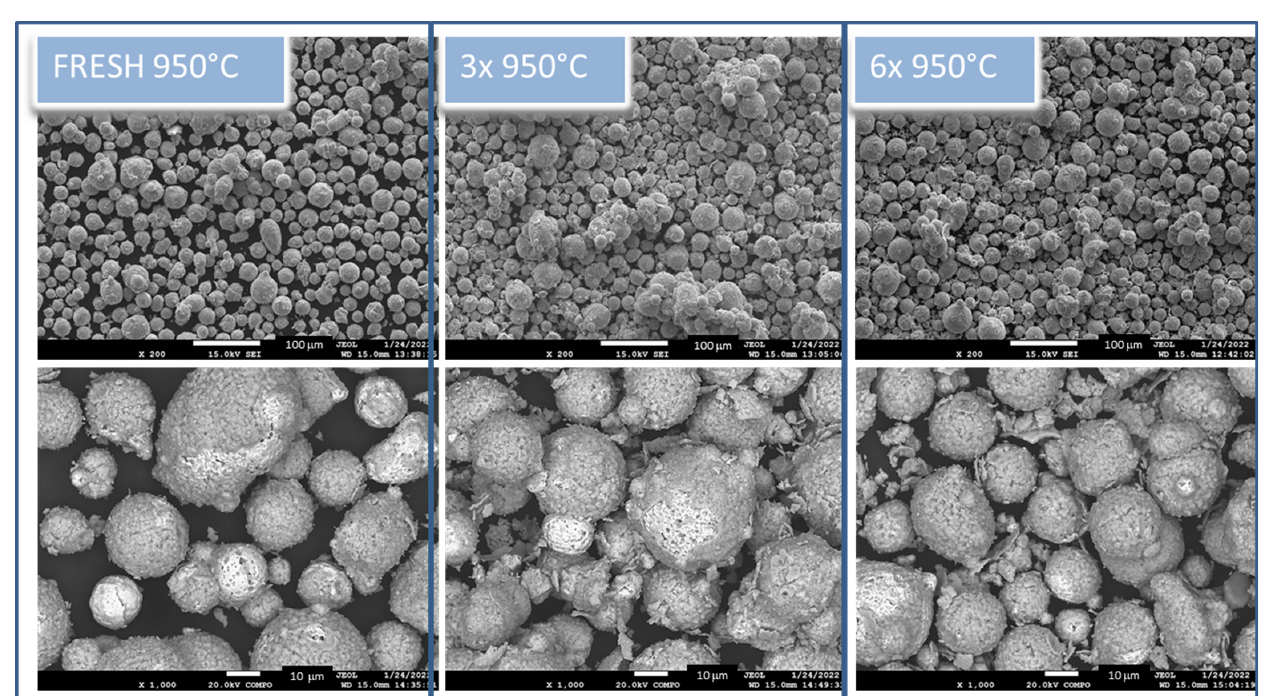
Figure 3. Morphology of all thermally treated powders in two magnifications: 200 × ( upper ) scale bar 1000 mm and 1000 × ( bottom images) scale bar 10 mm. In lower magnification, the morphology changes and agglomeration of particles is visible in the mode of secondary electrons. Chemical composition changes and Z-contrast are better observed on magnified pictures in the mode of backscattered electrons.